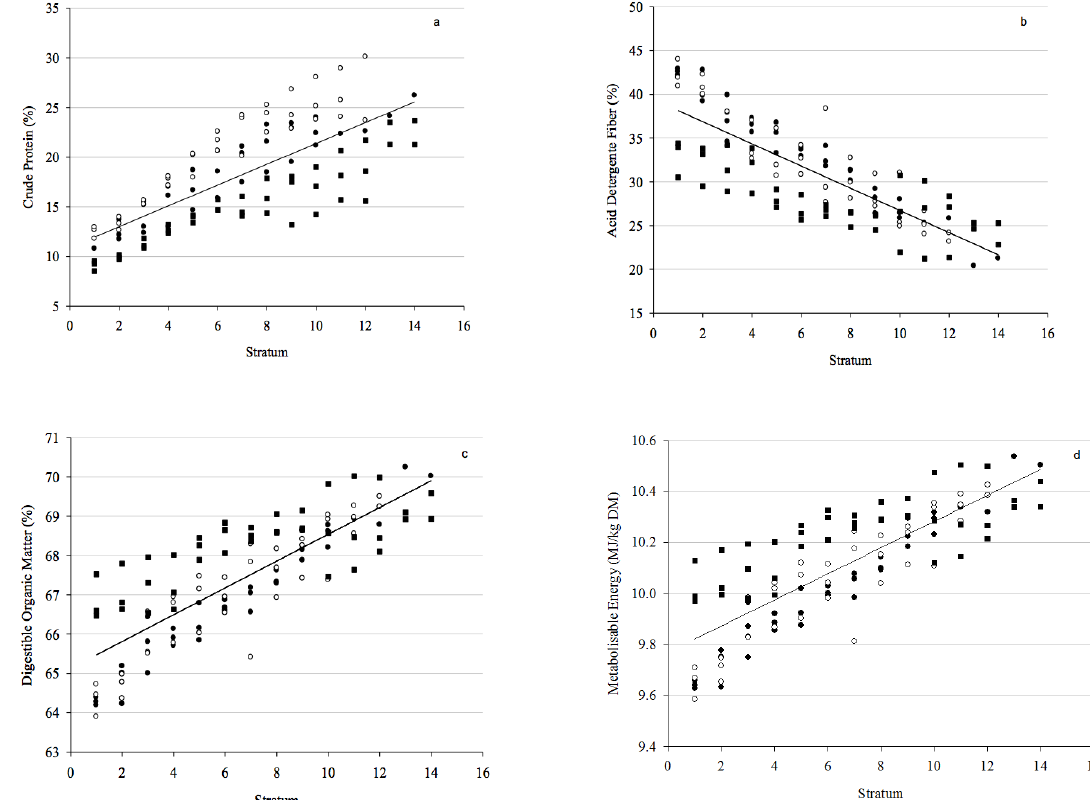
Figure 1. The association between crude protein (CP) ( a ), acid detergent fiber (ADF) ( b ), organic matter digestibility (OMD) ( c ), metabolizable energy (ME) ( d ), and pasture stratum (in cm) for Farm 1 (black circle), Farm 2 (white circle), and Farm 3 (black square). a: 10.9 + 1.05x, R 2 = 0.58, p < 0.0001; b: 39.4 − 1.27x, R 2 = 0.67, p < 0.0001; c: 65.1 + 0.34x, R 2 = 0.67, p < 0.0001; d: 9.8 + 0.05x, R 2 = 0.67, p <